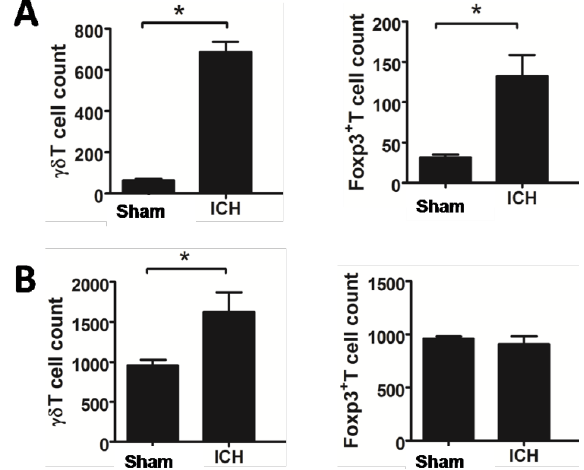
Figure 2. Increased absolute numbers of γδT and Treg cells in the brain and peripheral blood after ICH. The absolute numbers of γδT and Treg cells were increased significantly in the brain ( A ) and peripheral blood; ( B ) after ICH. ( n = 8 in each group) * p < 0.05 versus sham